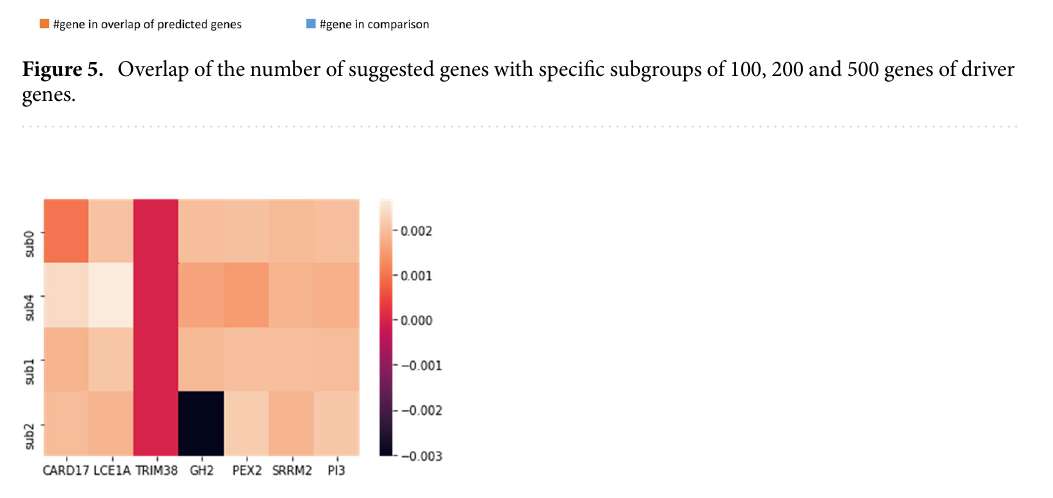
Figure 6. The amount of distribution p value of driver genes in the proposed method among specific